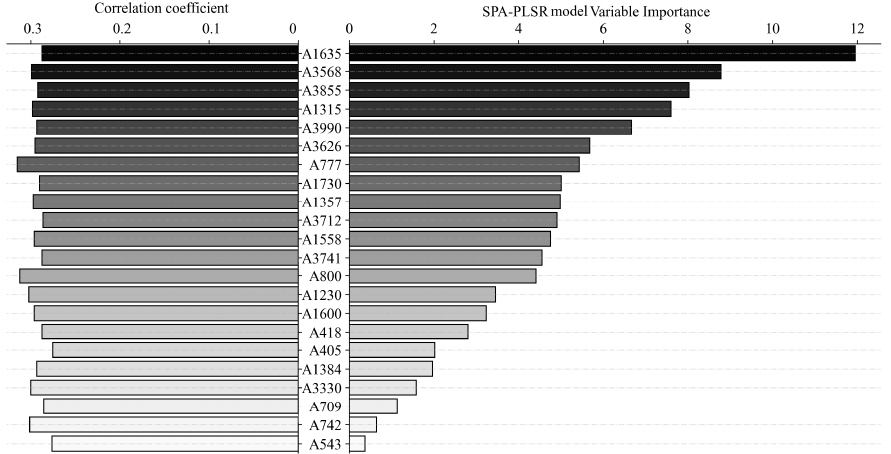
Figure 6. The SPA–PLSR inversion model variable importance and the Pearson correlation coefficient between the variable (wavelength) in SPA–PLSR inversion model and soil available potassium. Note: The vertical axis of the graph (such as A1635) represents the variable (wavelength) in the SPA–PLSR inversion model .